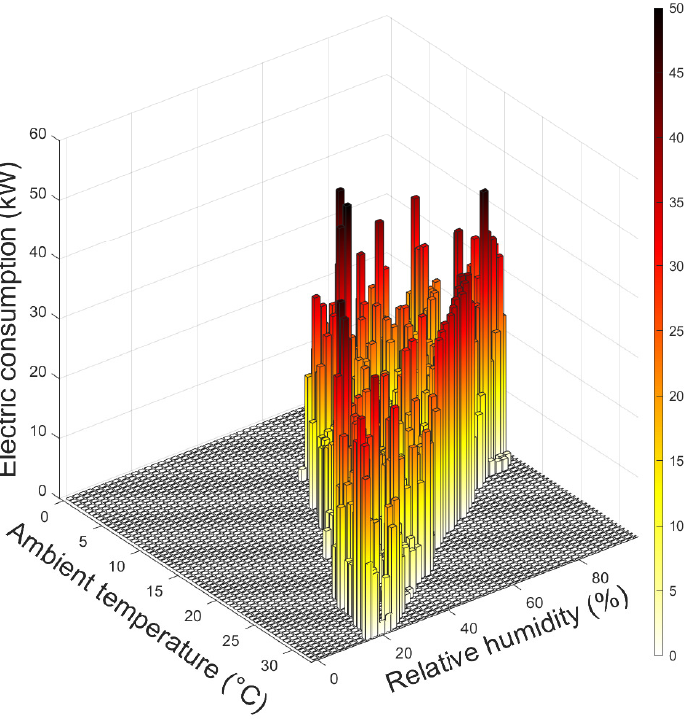
Figure 5. Energy signature of the building as a function of outdoor ambient temperature and outdoor relative humidity.